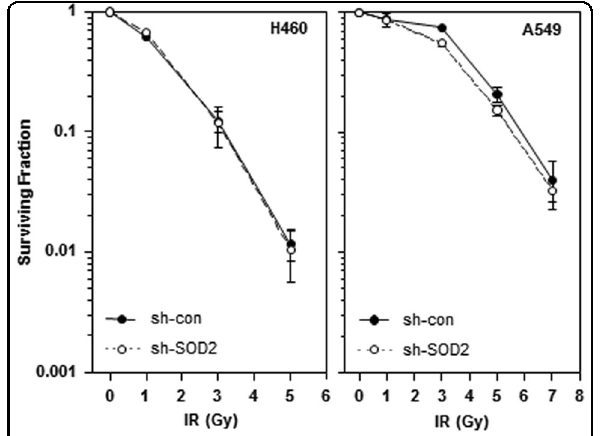
Fig. 5 SOD2 does not in fl uence radiosensitivity of H460 and A549 cells. H460 and A549 cells were infected with lentiviruses expressing a control or SOD2-targeting shRNA and irradiated with the indicated doses of γ -rays, and cell survival was then analyzed by clonogenic assays